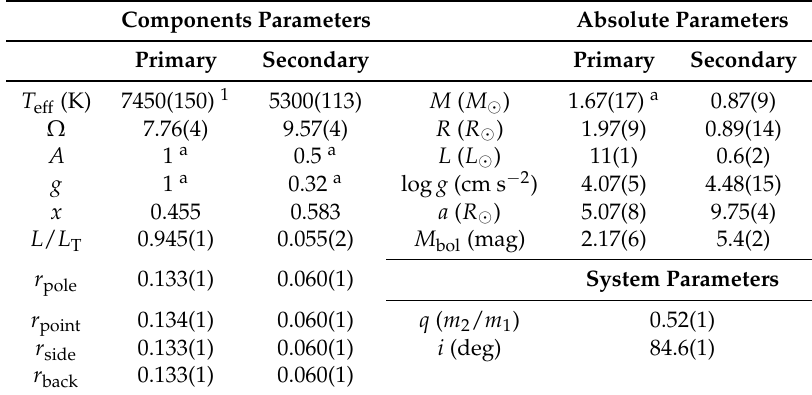
Table 1. LC modelling and absolute parameters for KIC 8504570. The errors are given in parentheses alongside values and correspond to the last